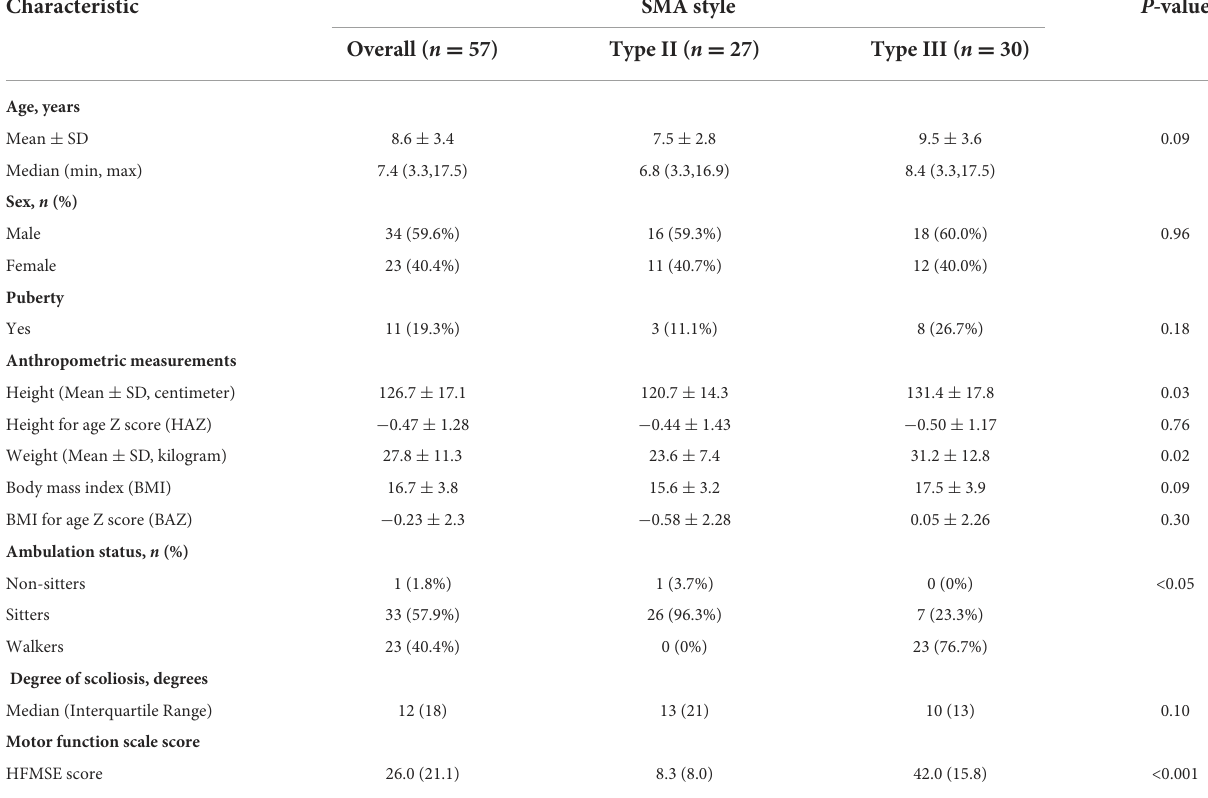
TABLE 1 Participants